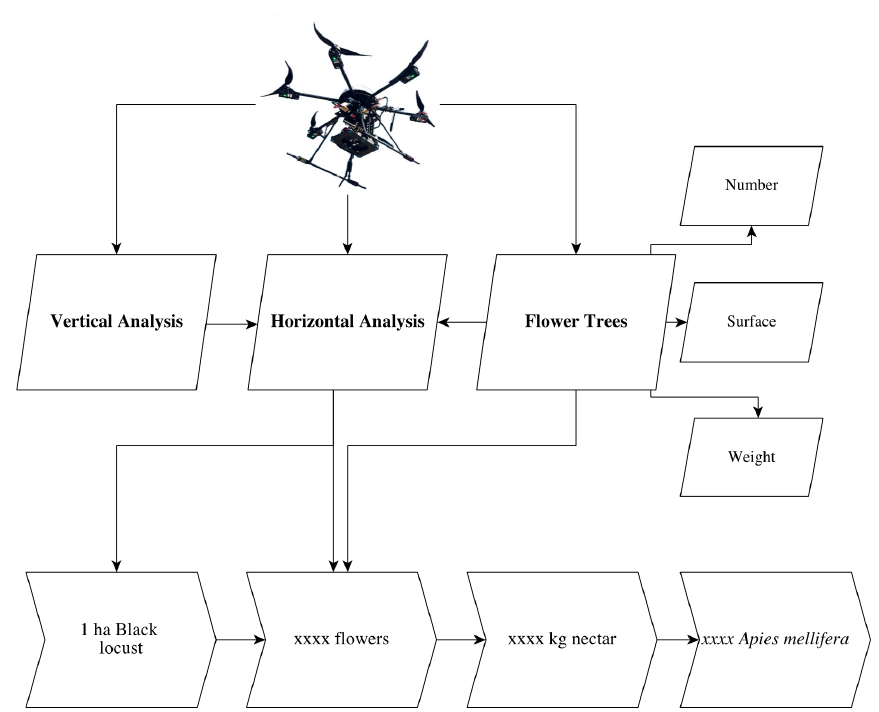
Figure 1. Flow chart showing analysis procedure (Vertical, Horizontal Analysis, and Flower Trees) to estimate flowers per tree and hectare, mass of nectar in kg, and number of Apies mellifera [56,73].